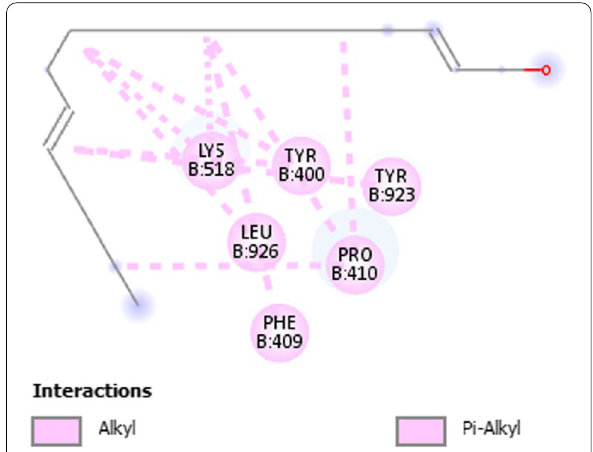
Fig. 11 2D interaction of compound 2 with crystal structure of S .